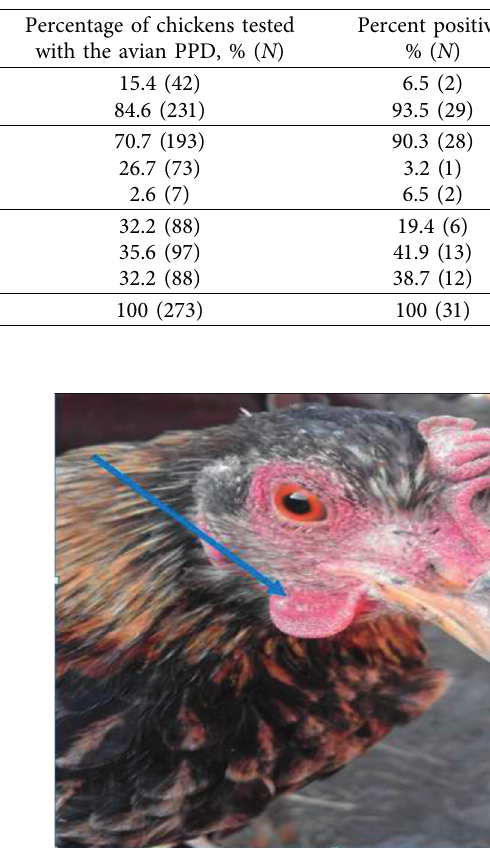
Table 1: Summary of the spatial distribution of chickens tested with avian tuberculin test in the present study and prevalence of avian TB with sex, breed, and altitude.